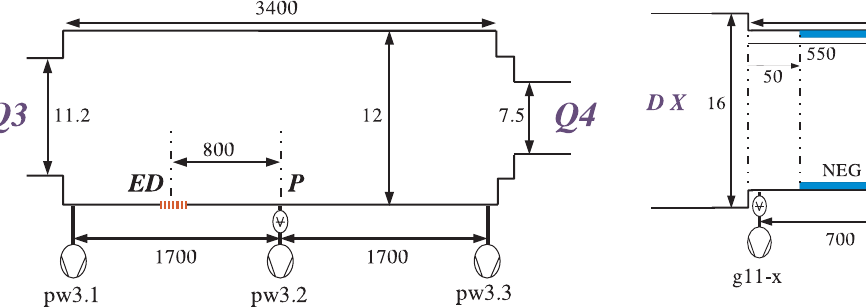
4. (Color) Geometry of the single beam pipe BO2, made of stainless steel and unbaked during 2003. The electron detector location (marked with ED ) is about 8 m away from the pressure gauge and ion pump, whose location is marked with P . Distances are given in cm and are not to